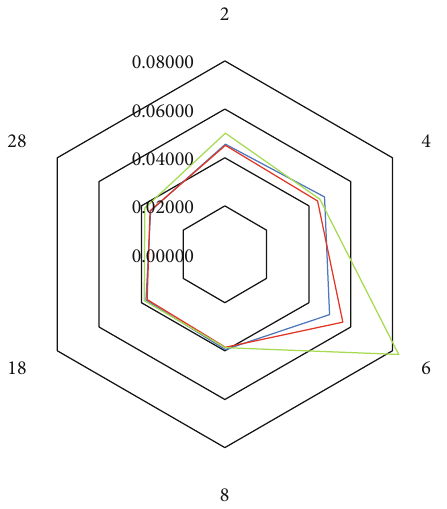
Figure 5: Overall criterion score of each recipe based on AHP analysis. Blue: recipe A; red: recipe B; green: recipe